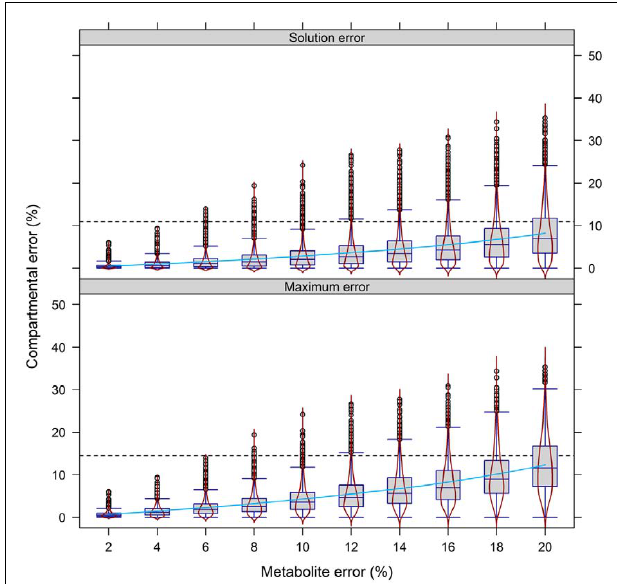
FIGURE 8 | Calculation error of compartmental abundances in dependence of the metabolite error based on experimental data. Compartmental abundances are estimated using BFA and visualized as absolute mean–average difference over the three independent gradients. The 95th percentile among all metabolite error levels is drawn as black dashed lines.The light-blue solid line shows a fitted smooth curve to illustrate the increase of the estimated compartmental error with increasing metabolite